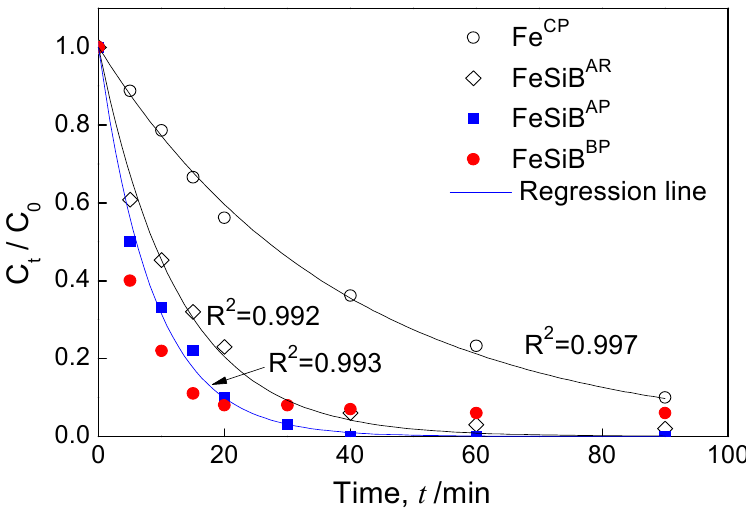
Figure 3. The normalized concentration of Pb 2+ ions dependence on the reaction